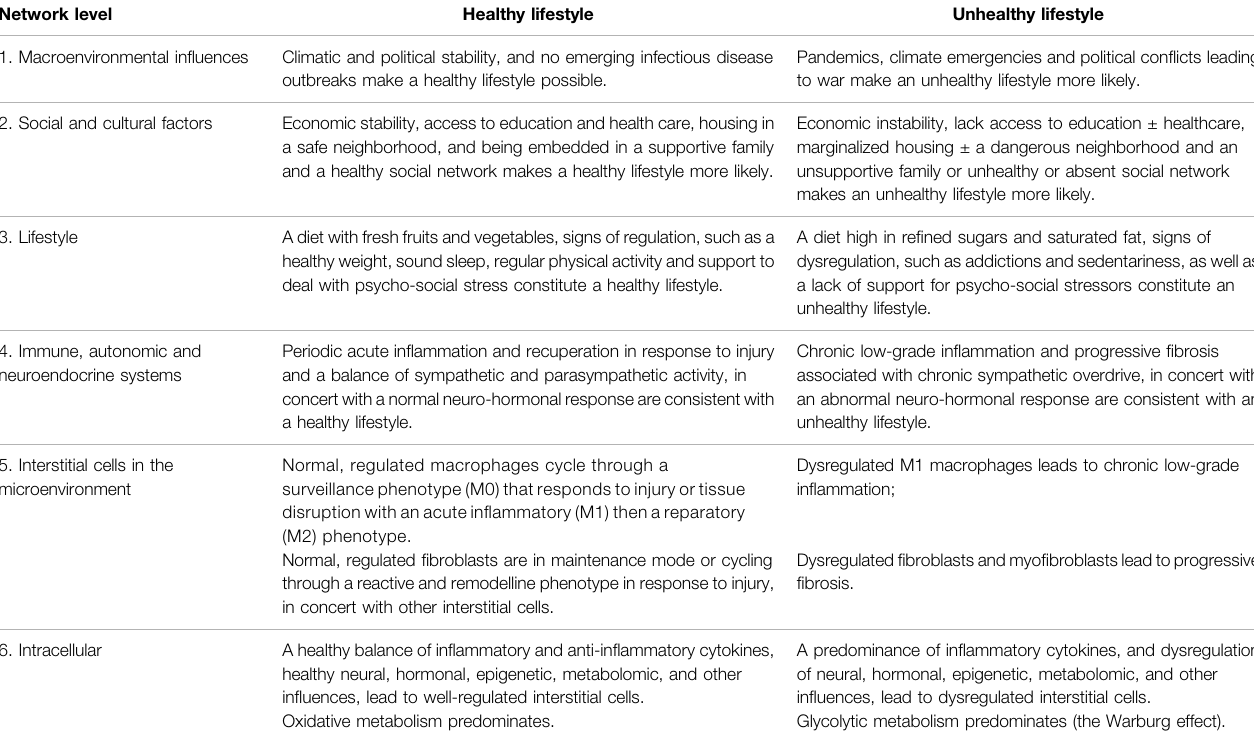
TABLE 3 | The features of a healthy and unhealthy lifestyle in the hierarchical six-layer network. Network